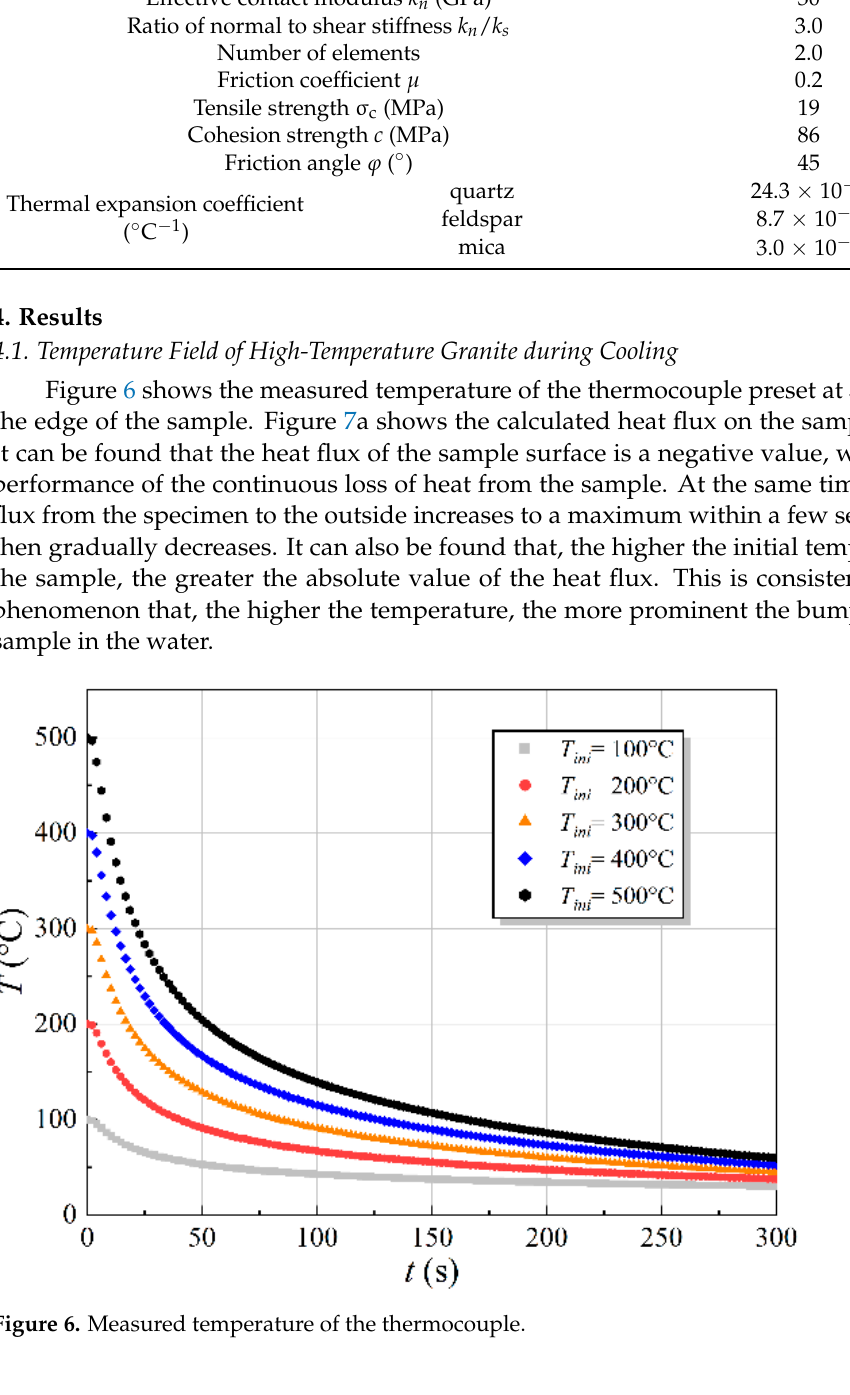
Figure 7. Heat conduction characteristics of high temperature granite subjected to water cooling: ( a ) heat flux on the sam- ple surface; ( b ) relationship between the heat transfer coefficient and the surface temperature. Figure 7b shows the relationship between the heat transfer coefficient and the surface temperature. The evolution of the heat transfer coefficient shows the similar trend as the heat flux. As the decrease of the surface temperature, the heat transfer coefficient first increase to the maximum value and then gradually decreases. According to the research of Collin et al. [39], the thermal-shock-induced tensile stress